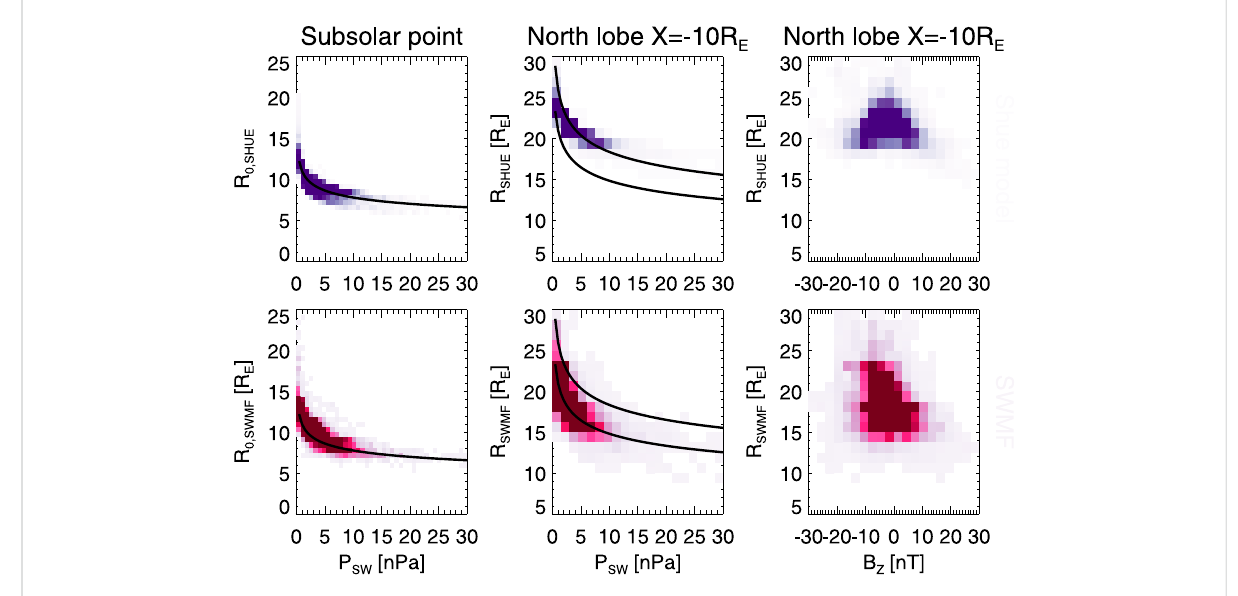
FIGURE 11 Magnetopauselocationvssolarwinddriverparametersduringthestormmainphase.(Left)Magnetopausesubsolarposition X -valuefor Y=Z=0 as function of solar wind dynamic pressure. (Middle) North lobe magnetopause position Z -value at Y = 0 , X = - 10 R E as function of solar wind dynamic pressure.(Right)Northlobemagnetopauseposition Z -valueat Y=0 , X= - 10R E asfunctionofIMF B Z .(Toprow)TheShuemodelvaluesareshowninblue, (Bottom row) the SWMF valuesare shown in red.The black linesshowtheShue model functionaldependenceondynamic pressure ( P { - 1/6.6} ) using arbitrary